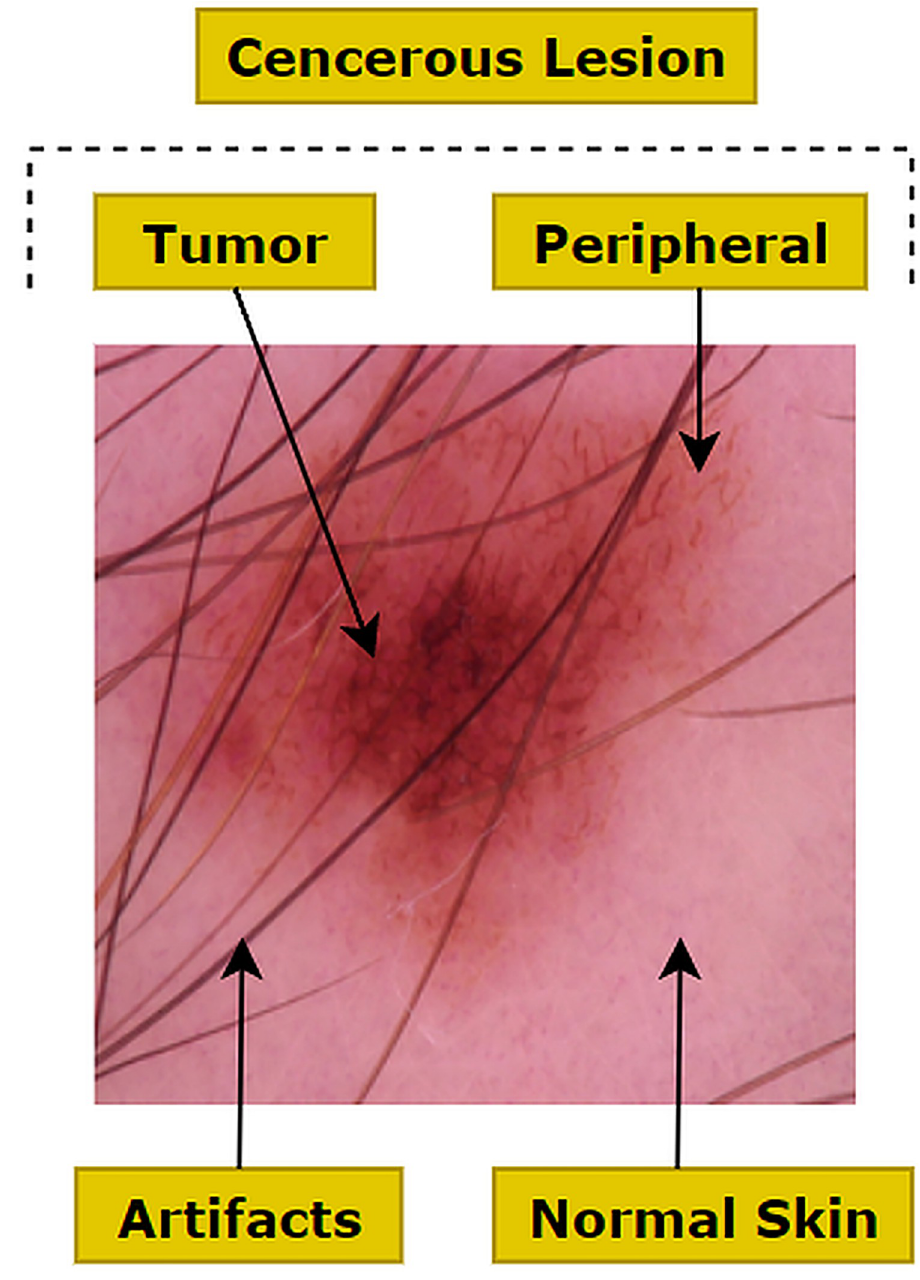
Fig 3. Three regions and artifacts in the skin lesion